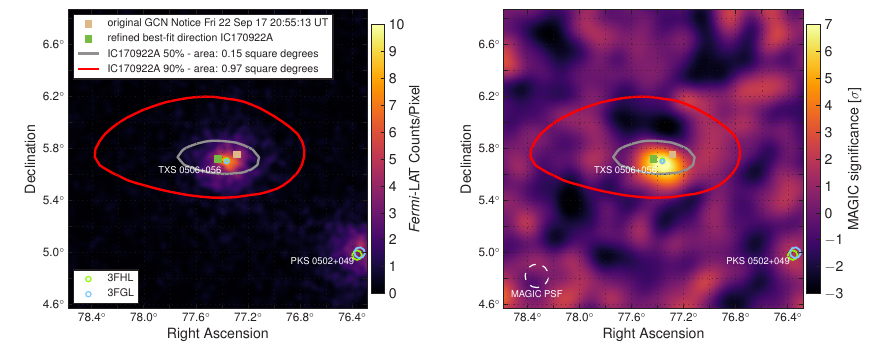
Figure 1. Adaptive binned gamma-ray light curve in the energy range from 300MeV to 1TeV. The Figure 2. Gamma-ray sky maps: The 50% and 90% containment neutrino error is shown in gray and vertical orange line shows the arrival time of IceCube-170922A and the orange band shows the duration red respectively. Left: Fermi -LAT counts map. Right: MAGIC significance map. Figures from of the lower-energy neutrino flare (see Finley et al. in these proceedings for more details). Figure adapted from [7].